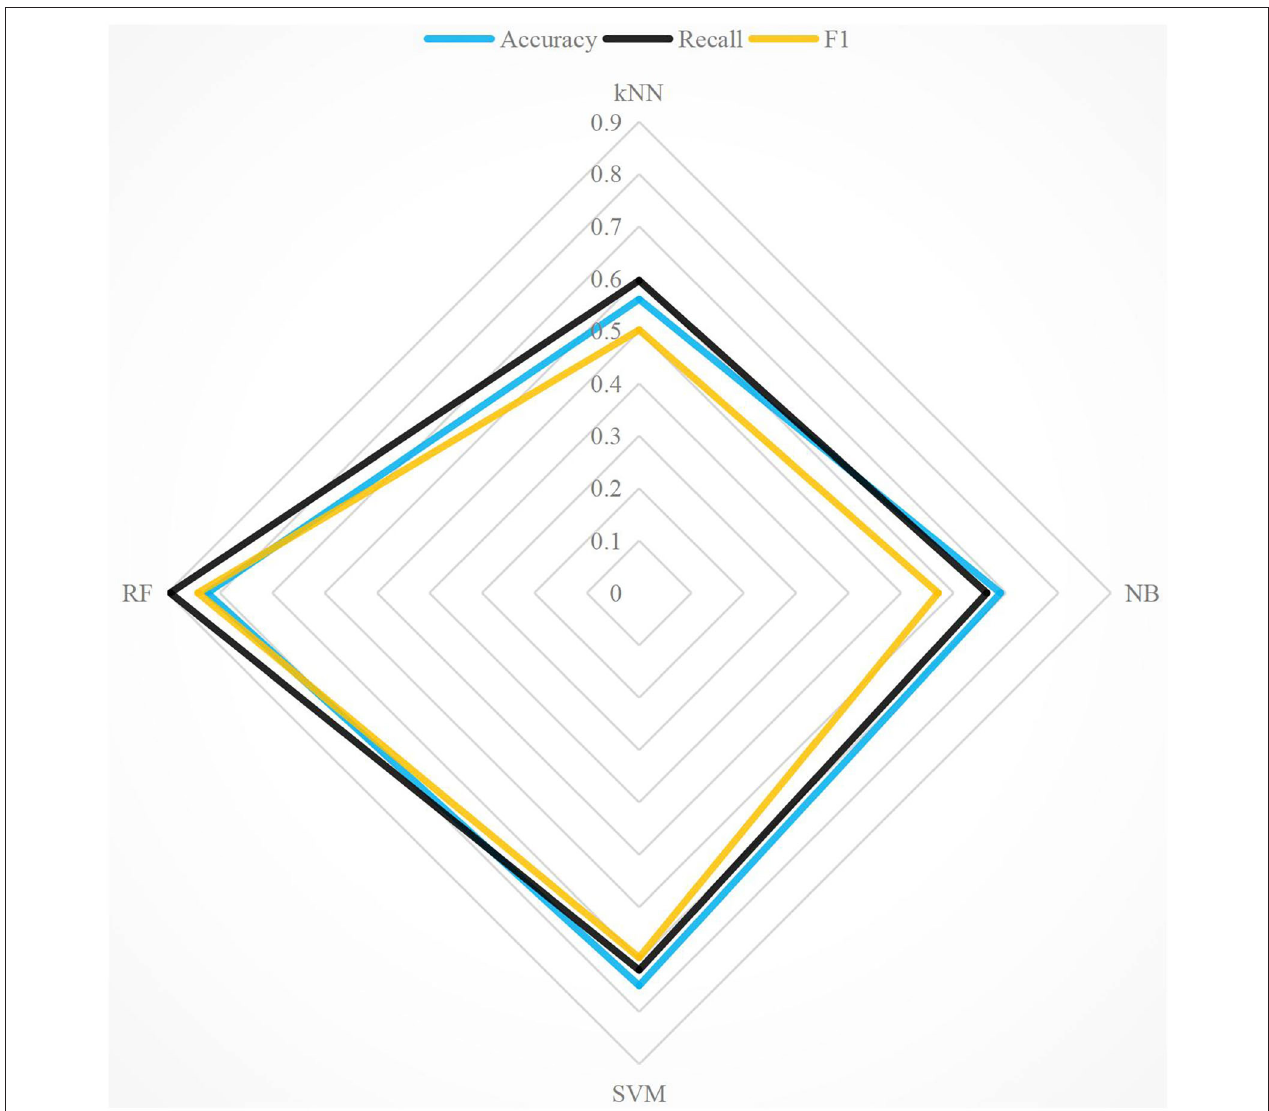
FIGURE 2 | Comparison of evaluation metrics with four methods under Beijing Language and Culture University Corpus Center (BCC)